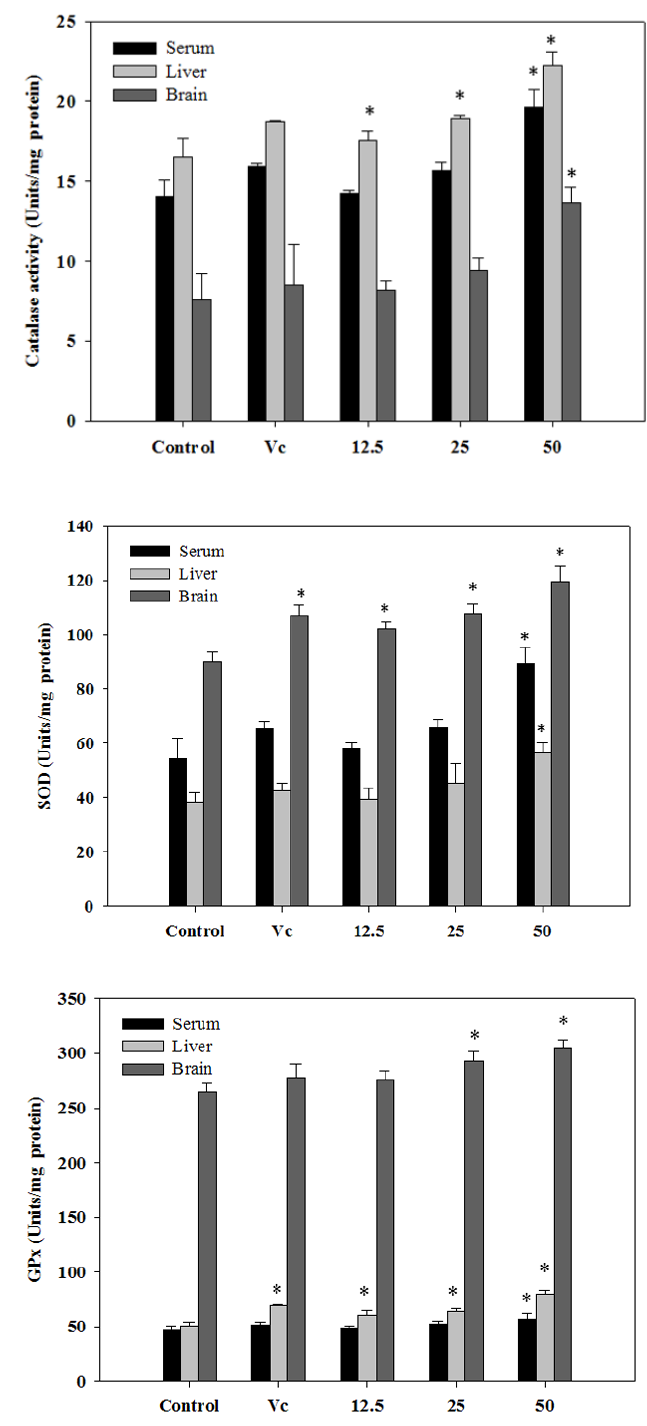
Figure 4. Effects of GSA on level of catalase (CAT) ( A ) SOD ( B ) and GPx ( C ) in serum, liver and brain of mice. Values are the mean ± SD ( n = 5); * p < 0.05 compared with normal control group. All activities were expressed as unit per milligram of protein (U/mg